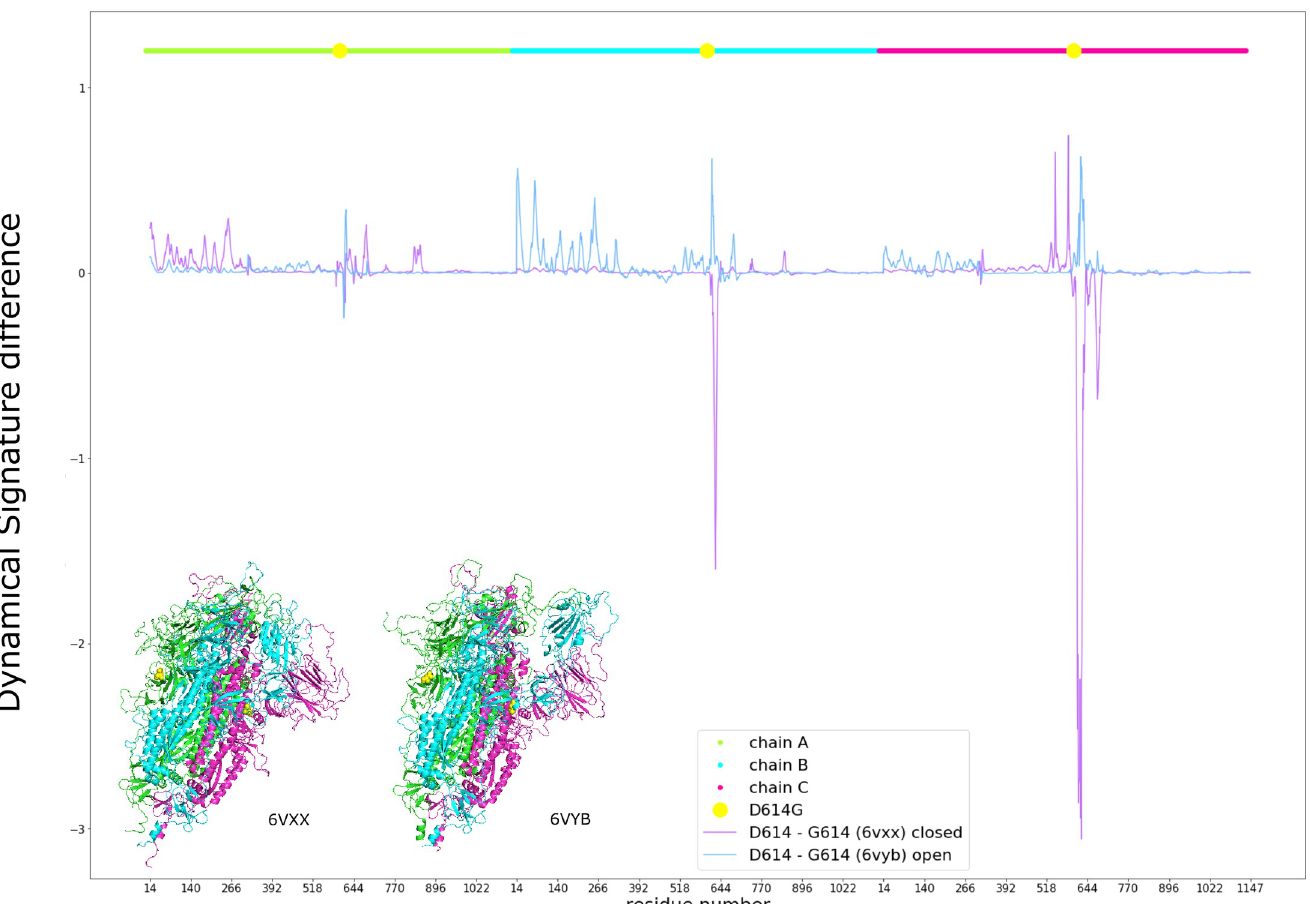
Fig 4. Effects of the D614G mutation on the Dynamical Signature of the closed (purple) and open B chain RBD (blue) structures, measured by the difference between the calculated b-factors of D614 and G614. Chains are represented in different colours and the position of the mutation is marked in yellow, using the same colours as for different regions of the structure as represented in the colours of the